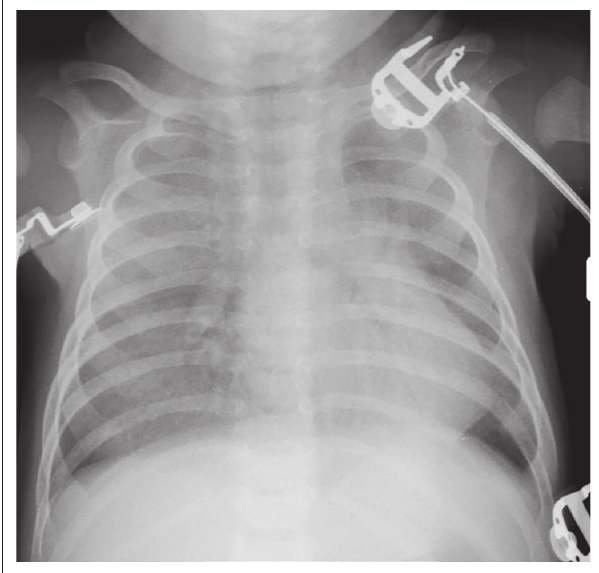
FIGURE 1: Infant boy with HIV infection who presented with respiratory distress and hypoxemia. Frontal chest radiograph shows diffuse bilateral ground glass opacification from PCP and CMV